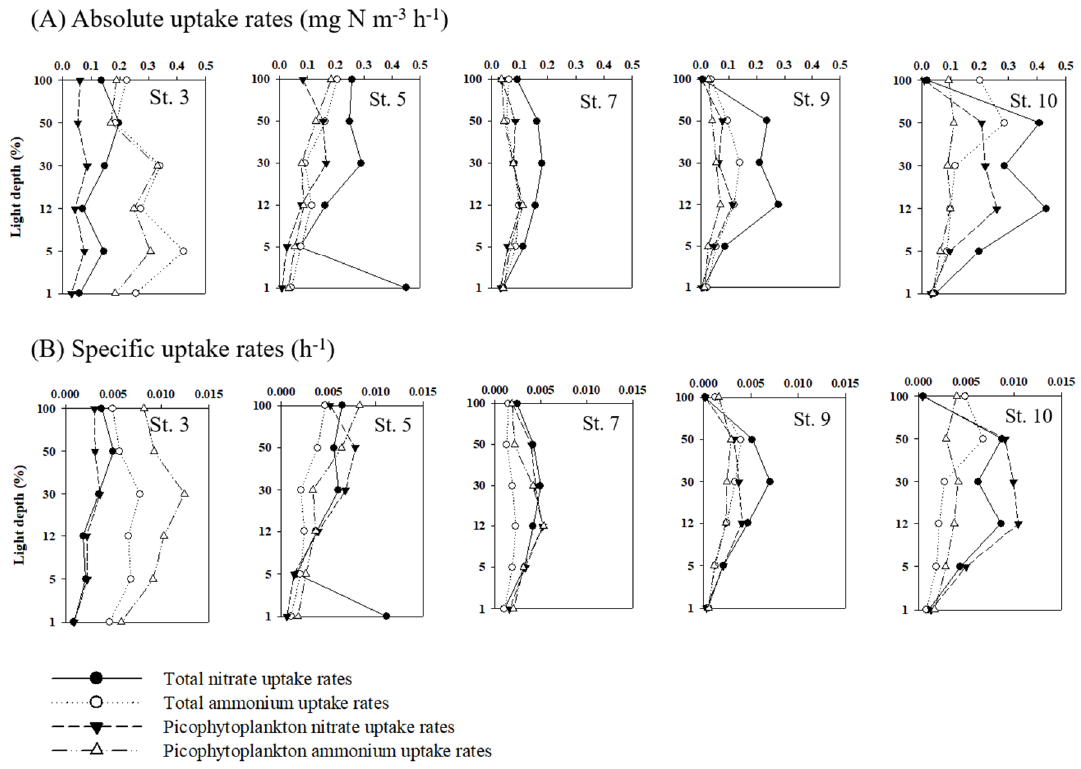
Figure 7. The vertical pattern of ( A ) absolute and ( B ) specific nitrogen (nitrate and ammonium) uptake rates for total and picophytoplankton at each light depth (100, 50, 30, 12, 5, and 1% light depth). The total hourly nitrate and ammonium uptake rates integrated from 100 to 1% light levels were